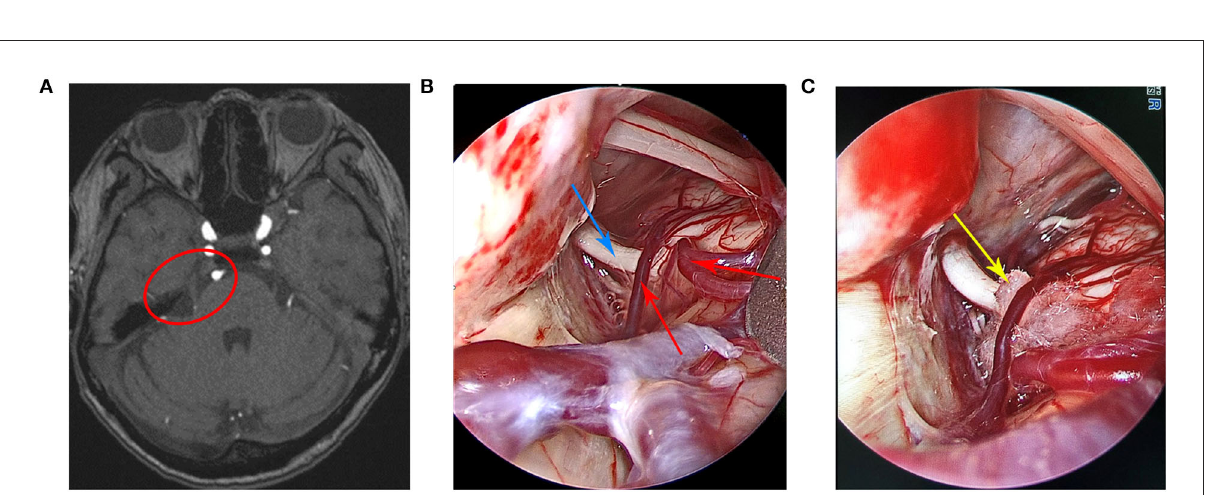
FIGURE2 (A) Preoperative head magnetic resonance imaging of the patient. (B) A small artery, a vein that spanned the right trigeminal nerve, and the trigeminal nerve were clearly visible under the endoscopic view. (C) The Teflon pad was placed between the trigeminal nerve and the offending vessels under the endoscopic view. The red circle indicates trigeminal nerve compression by the offending vessels, the red arrow indicates the offending vessels, the blue arrow indicates the trigeminal nerve, and the yellow arrow indicates the Teflon